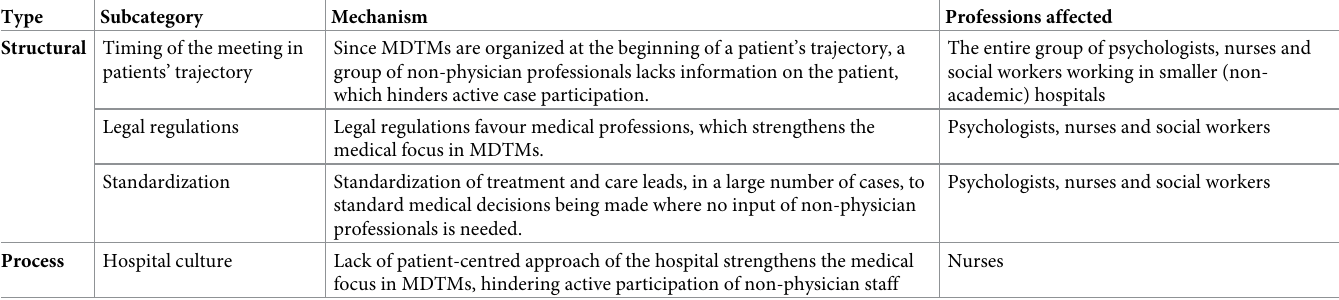
Table 4. External barriers to non-physician cancer care professionals taking up an active role during